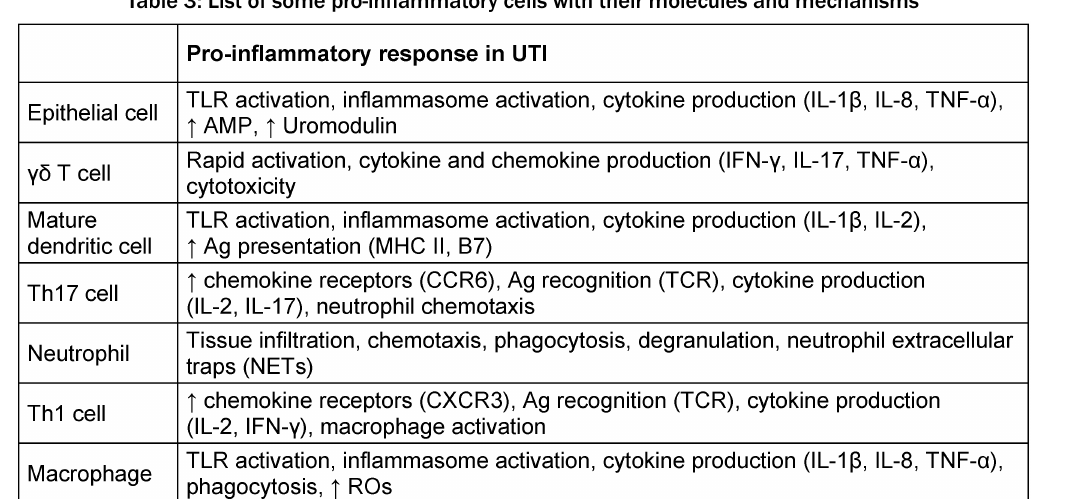
Figure 2: Uromodulin produced by urothelium inhibits adherence of UPEC; NGAL (neutrophil gelatinase-associated lipocalin) inhibits iron receptors blocking bacterial capacity to proliferate; cathelicidin and other antimicrobial peptides cause membrane lysis; pentraxin 3 (PTX3) opsonizes uropathogens and facilitates their phagocytosis by neutrophils and macrophages; epithelial cells activate inflammasome trough TLRs, producing pro-inflammatory cytokines; adaptive immune response also participates with B lymphocytes producing antigen-specific IgA neutralizing uropathogens. Table 3: List of some pro-inflammatory cells with their molecules and